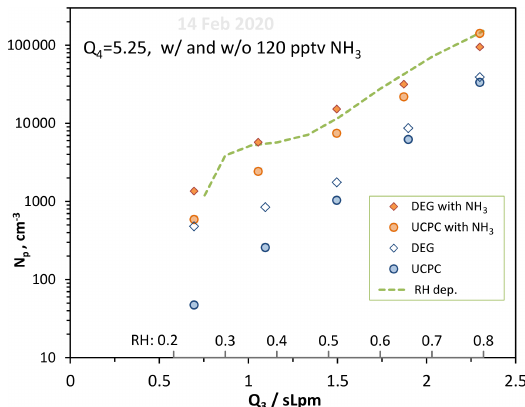
Figure 9. Variation in N p with Q 3 , a proxy for RH, with and with- out 120pptv NH 3 added. Q 4 = 5 . 25sccm and N p from both parti- cle counters are shown. RH varies from 23% to 81% over the range of Q 3 investigated. The Dunne et al. (2016) ad hoc RH dependency is shown, normalized to our measurements at Q 3 = 1 . 05slpm.